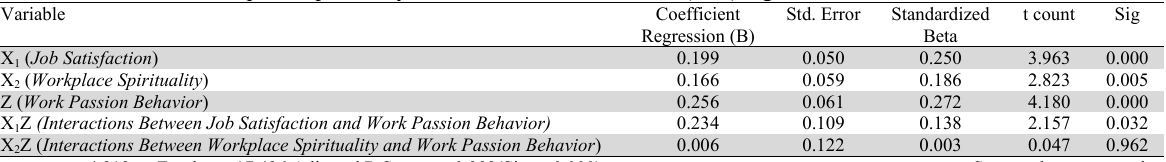
Results of X1, X2, Z Regression Analysis, Interactions Between Job Satisfaction and Work Passion Behavior (X 1 Z), and Interactions Between Workplace Spirituality and Work Passion Behavior (X 2 Z) Against Y